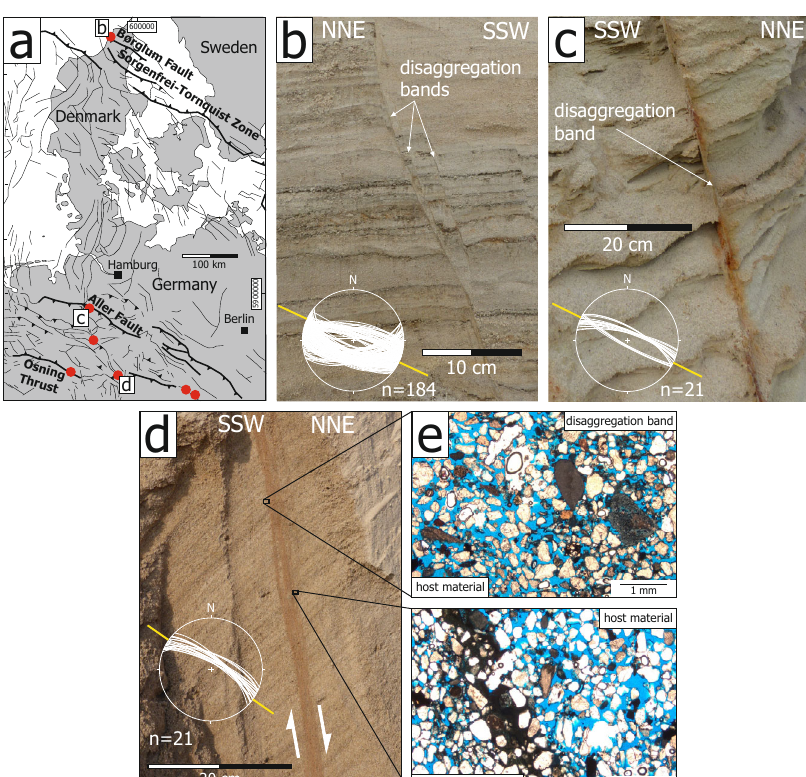
Fig. 1 Field examples of disaggregation bands developed in sandy sediments in the vicinity of blind faults. Each stereographic projection (lower hemisphere, equal area) shows the strike of the blind fault in yellow; the great circles represent the orientation of the disaggregation bands measured in the overlying sediments. a Fault map of Central Europe, modi fi ed after 58 . Red dots indicate outcrops of disaggregation bands in northern Europe, data this work and 59 . b Børglum Fault (northern boundary fault of the Sorgenfrei-Tornquist Zone, northern Denmark). c Aller Fault, northern Germany. d Freden site, northern Germany. e Thin-section photographs of a disaggregation band and host material from d . Note the low pore-space within the band.